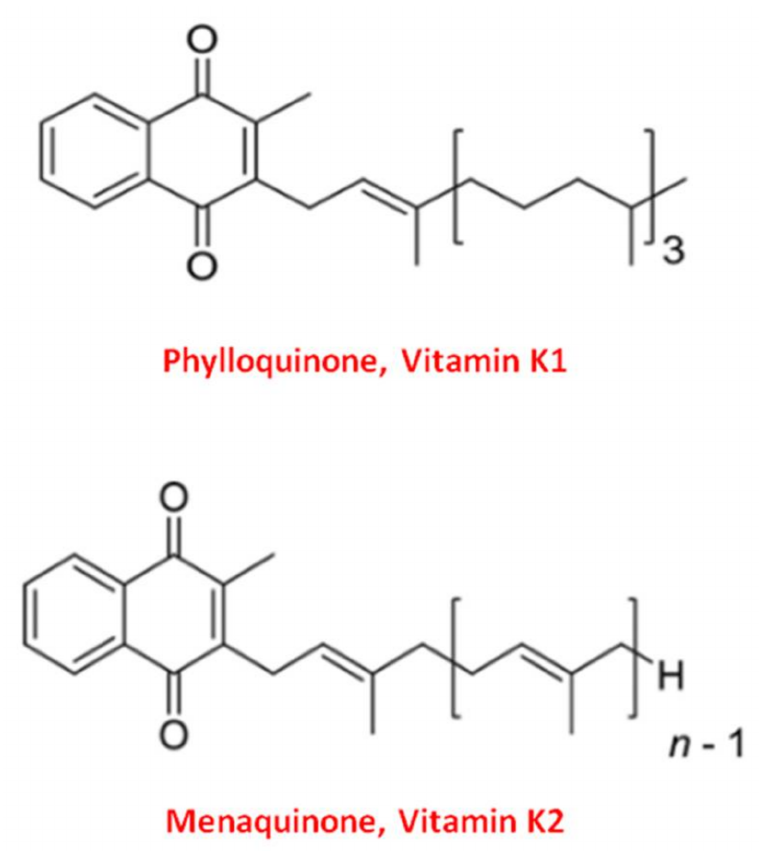
Figure 1. Molecular structure of the two main forms of Vitamin K. The upper structure represents Vitamin K1, also known as phylloquinone. The bottom structure is Vitamin K2, also known as menaquinone